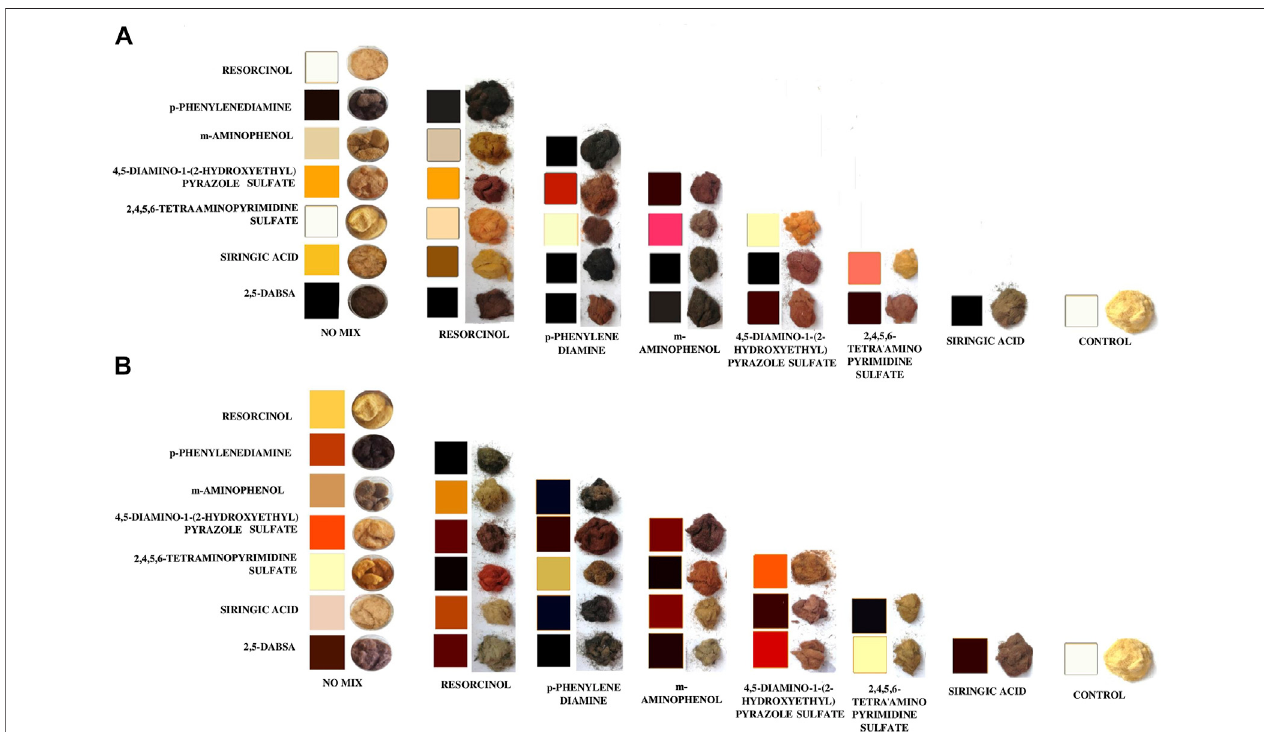
FIGURE 4 | Wood fi bers dyed through laccases incubation together with single or coupled monomers in a dyeing bath at pH 3 (A) and pH 9 (B) . The wood fi ber color of each combination was compared with the color related to the corresponding solution.